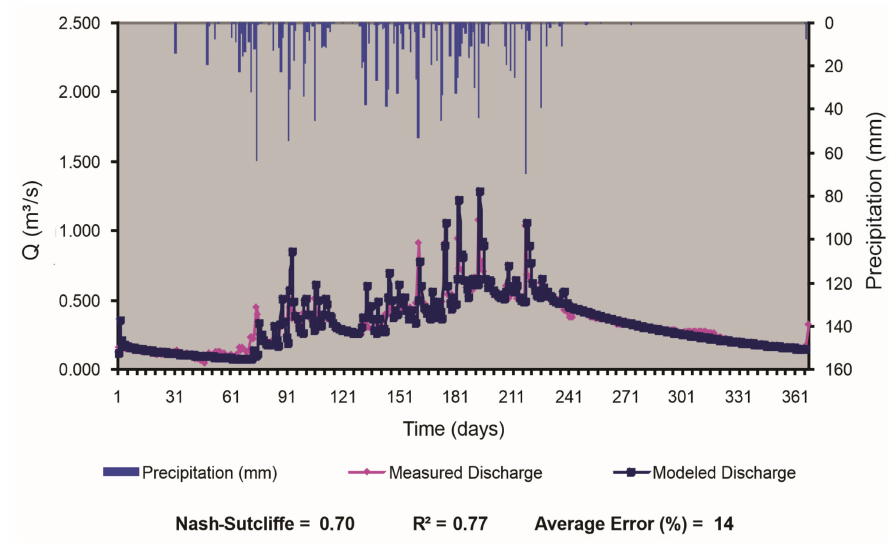
Figure 9. Measured versus modeled discharge (calibration).